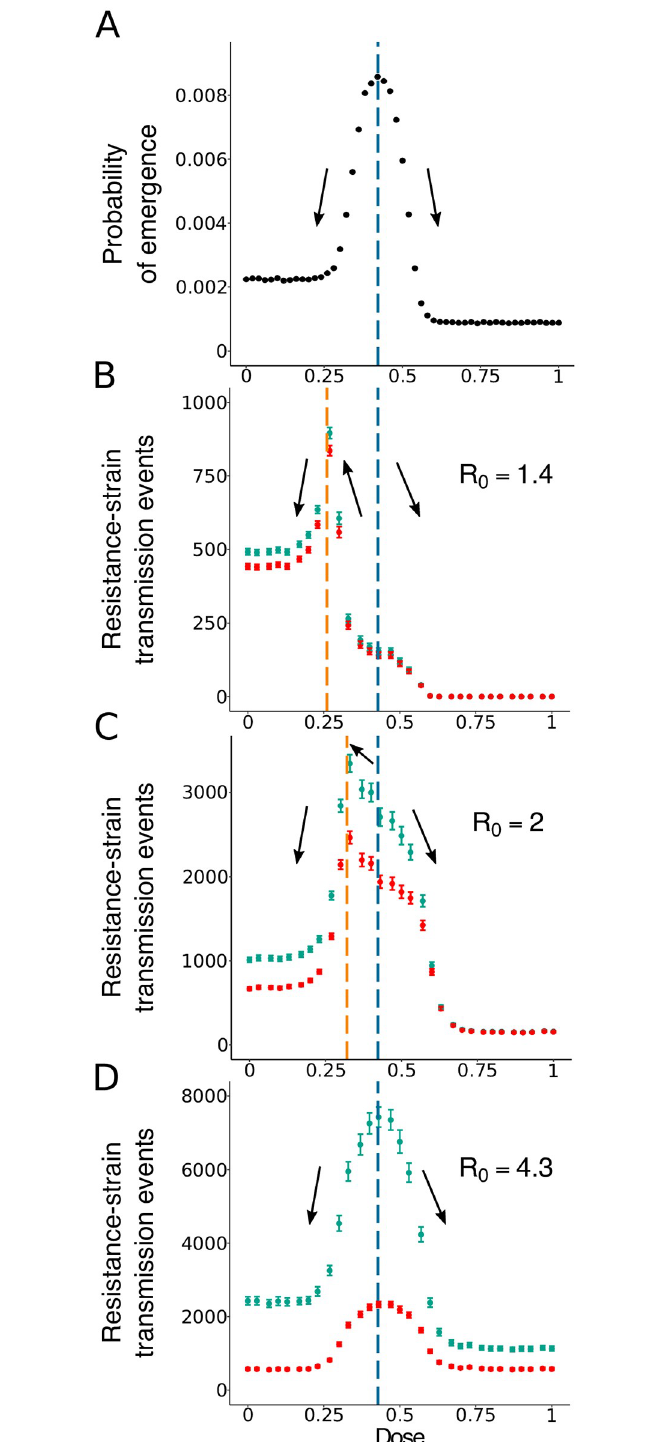
Fig 3. Comparison of optimal dose determined through the within-host probability of resistance (A) or through the number of transmission events of the resistant strain during an epidemic (B-D). Blue symbols show the total number of transmission events, while red symbols show only transmission events towards susceptible hosts. The vertical blue line corresponds to the peak in the within-host probability of resistance and the orange line to the peak in the number of resistant-strain transmission events. The black arrows represent the trends in the number of